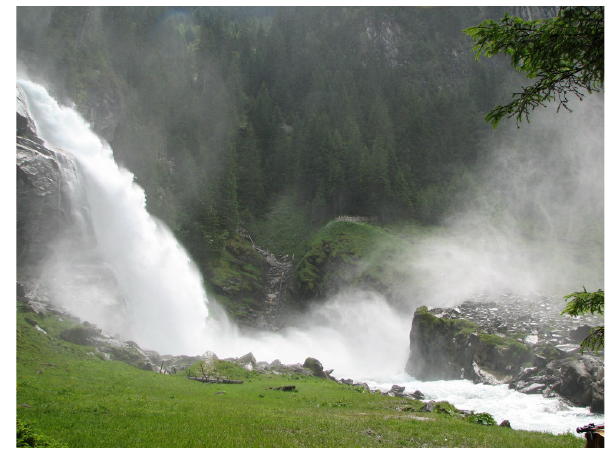
Fig. 5. The last of three cascades at the Krimml WF.